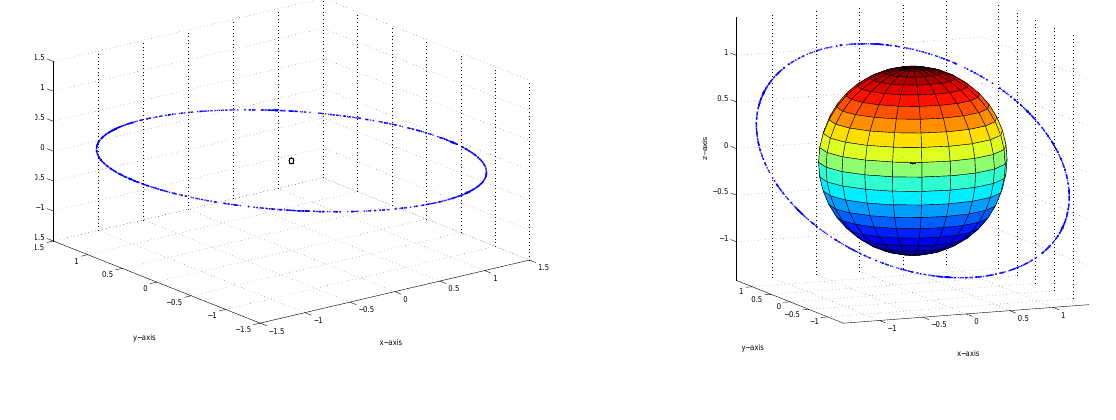
Figure 11. Set of fixed points + unit sphere from different